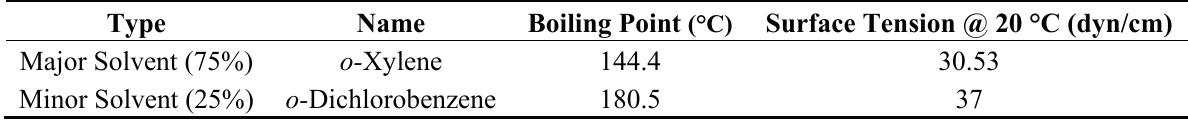
Table 4. Selected solvent mixture pair for experimental part IV and their